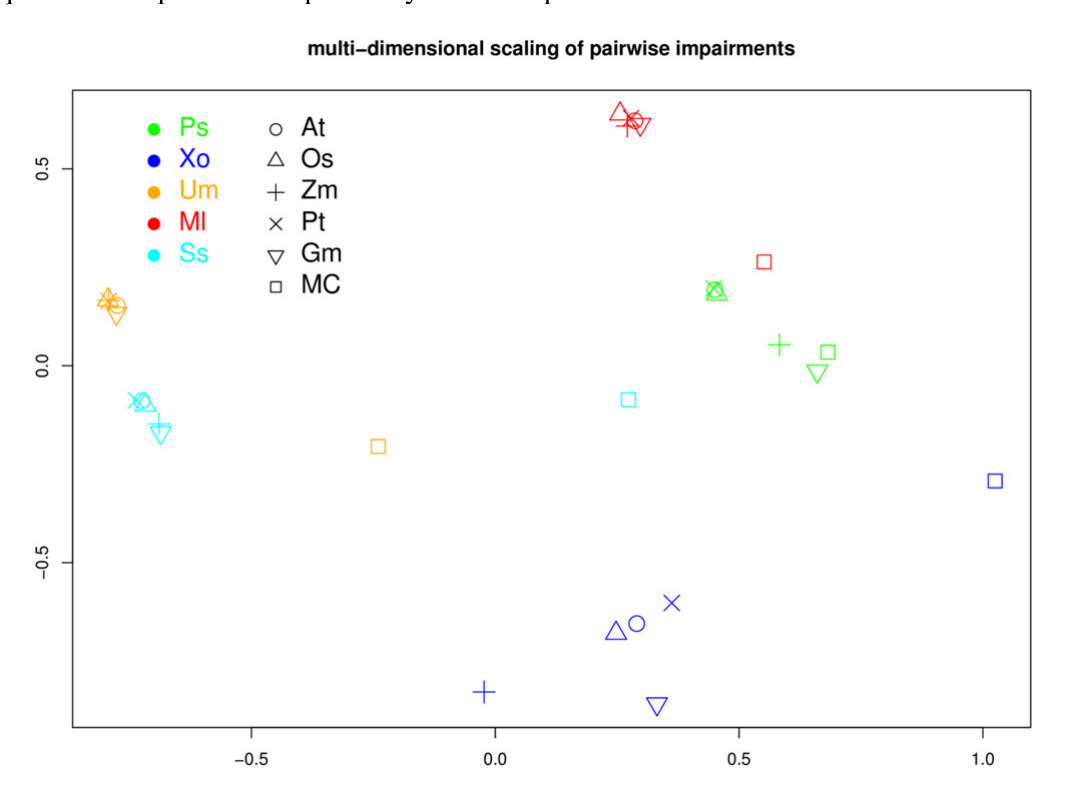
Figure 5. Multi-dimensional scaling (MDS) of all pairwise impairment patterns. Each colored symbol represents one host-pathogen pair, where hosts are characterized by different symbols and pathogens by different colors. Similar impairment patterns are located near each other in the plot. Axes denote the two-dimensional space in which the respective data points were placed by the MDS